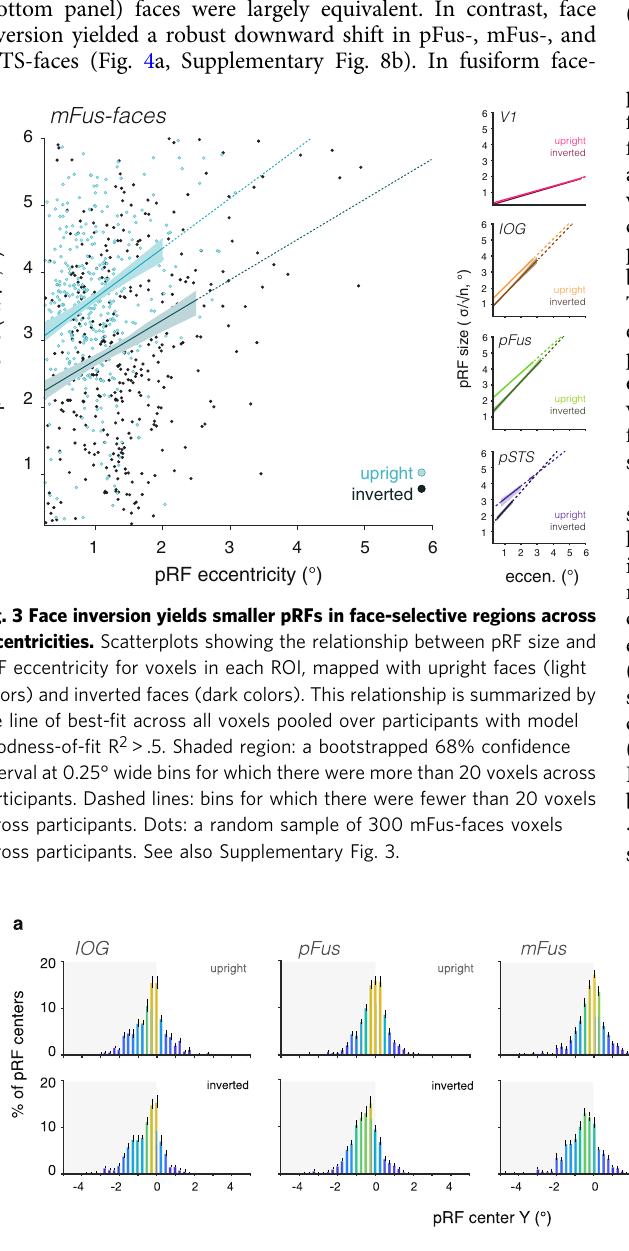
Fig. 4 In face-selective regions, pRFs differ in their vertical position with face inversion. a The average distribution of pRF center vertical position (Y) when mapped with upright (top row) and inverted (bottom row) faces. Distributions are computed for each participant, and then averaged across participants ( N = 12). Error bars: ±SEM across participants in each 0.25° bin. b Position shifts for a random subsample of 300 mFus-faces voxels across participants for which the model variance explained is higher than 50% of the variance; voxel pRF center position estimates are consistently shifted